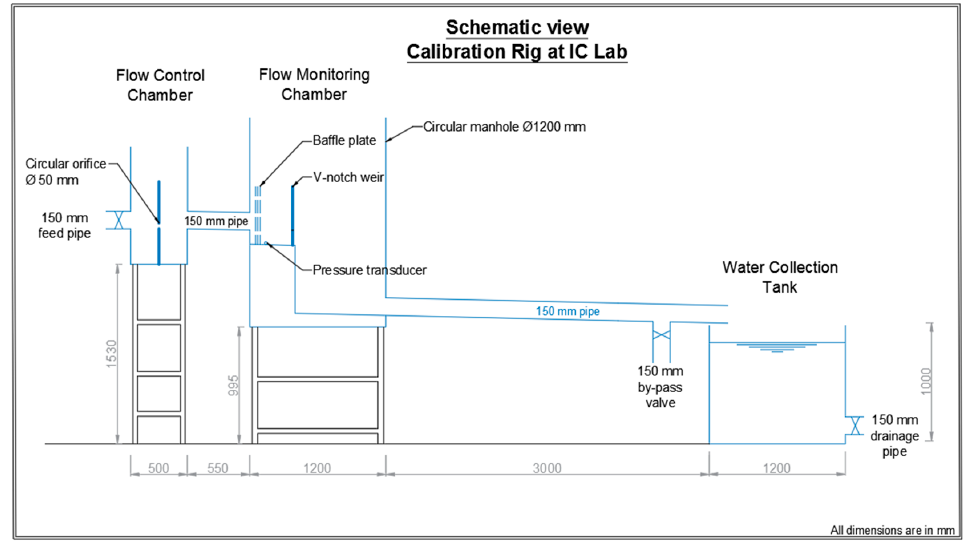
Figure 2. Calibration rig set-up for V-notch measurement of Green Infrastructure (GI) performance.